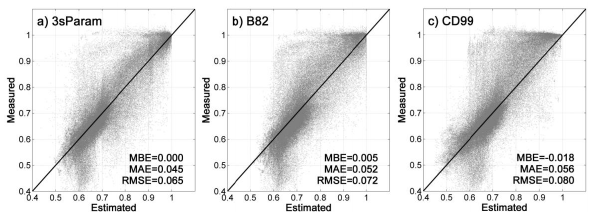
Fig. 7. Atmospheric emissivity measurements versus estimation obtained for the simulation at C Station (1332 m a.s.l.) using the three different schemes locally calibrated with RP data.